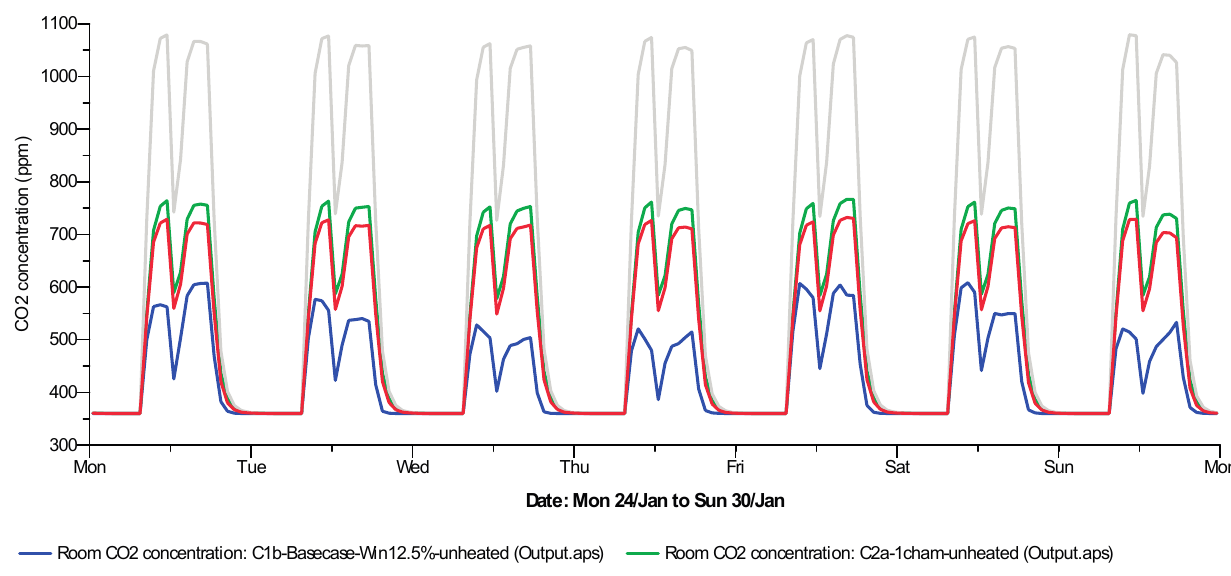
Figure 2. Concentration of carbon dioxide in Cases 1b, 2a, 2b and